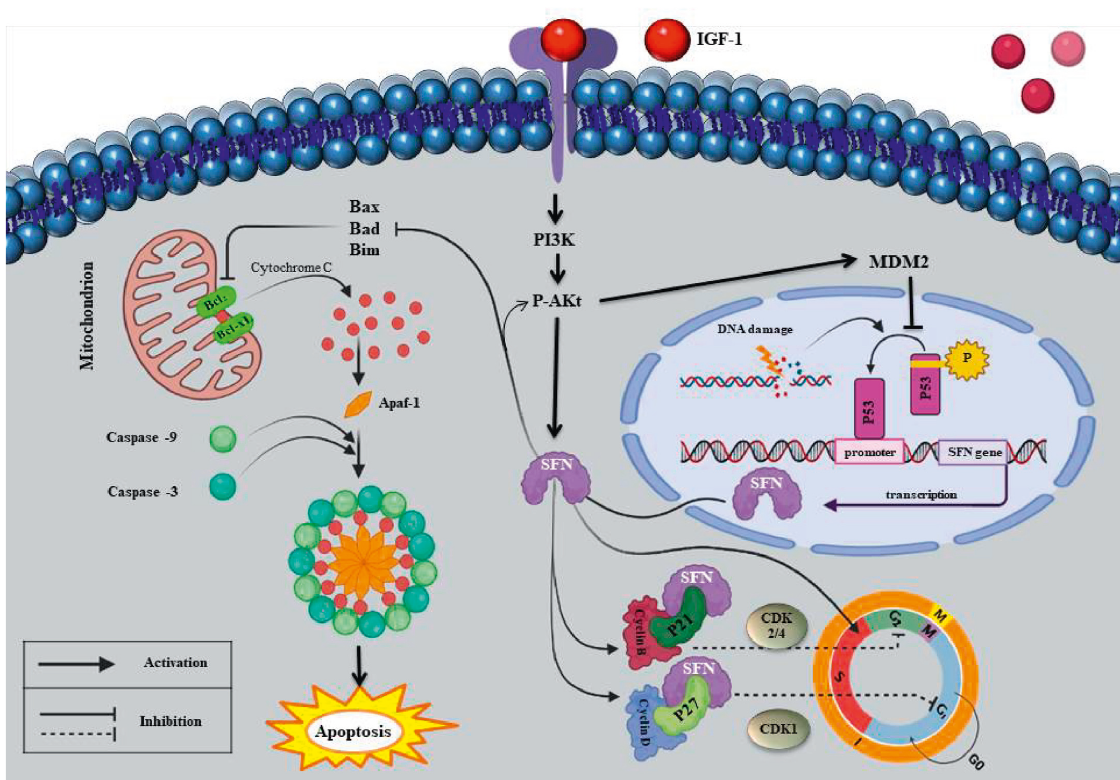
Figure 9: Possible mechanisms of SFN role in tumorigenesis. Although SFN dependent on P53 induces the cell cycle arrest, it can prevent apoptosis by sequestrating Bad and Bax, which symbolizes an excellent capability of SFN as an oncogene [65]. In addition, it may have roles in proliferation, growth, motility, differentiation, and metabolism through PI3K/Akt pathway